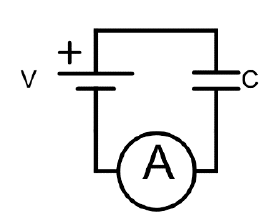
Figure 5. Circuit diagram for breakdown voltage measurements. The power supply ( V ) is directly connected to the capacitor ( C ), so the current flowing through the device can be simply monitored by the ammeter ( A ). A linear increase in the current read by the ammeter indicates the loss of the insulating properties of the capacitor.